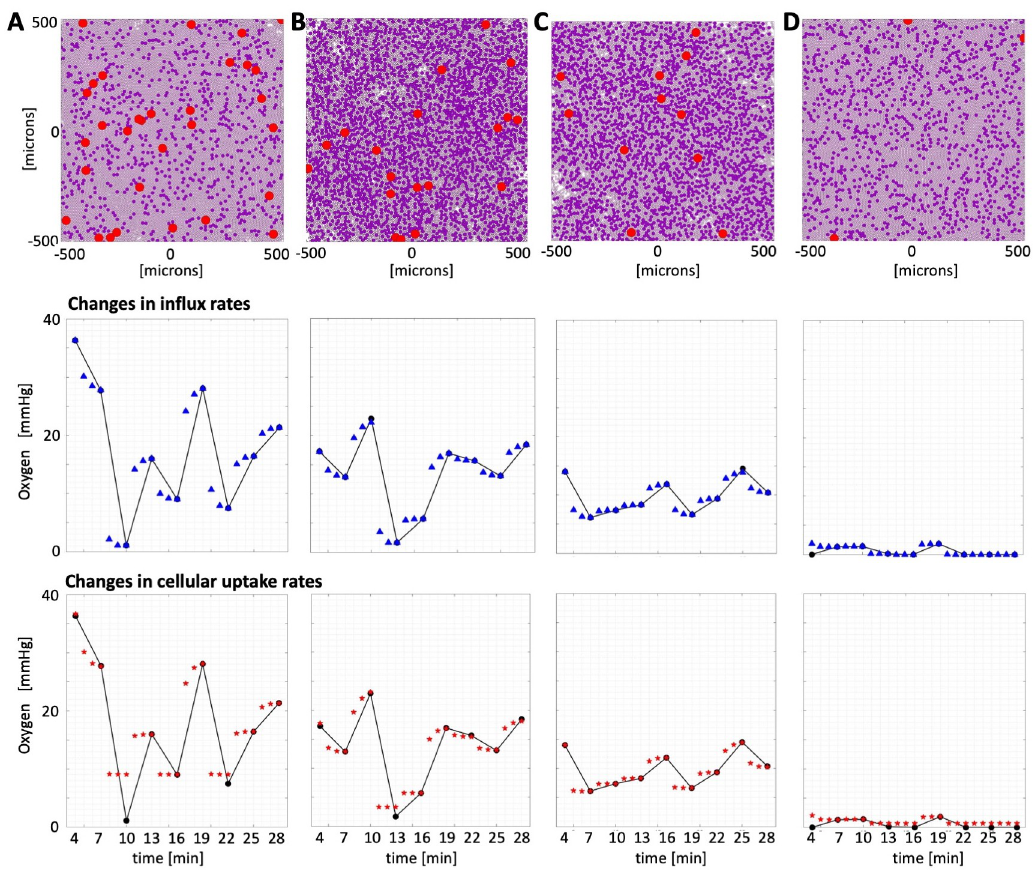
Fig 4. Reconstruction of oxygen fluctuations in ROIs #1–4. Tissue configurations (top row) for which numerically stabilized oxygen distributions matched the maximum average pO 2 level in each of the region of interests and the reconstructed pO 2 fluctuations when either vascular influx rates (middle row) or cellular uptake rates (bottom row) were varied. Straight lines connect experimental data recorded every 3 minutes. Blue triangles (top, influx) and red stars (bottom, uptake) denote computational data recorded each minute. Tissue characteristics: A. ROI#1 (black): vascularity 4%, tumor cellularity 15%, and stromal cellularity 75%. B. ROI#2 (red): vascularity 2.5%, tumor cellularity 45%, and stromal cellularity 40%. C. ROI#3 (blue): vascularity 1.5%, tumor cellularity 40%, and stromal cellularity 45%. D. ROI#4 (magenta): vascularity 0.5%, tumor cellularity 20%, and stromal cellularity 75%.